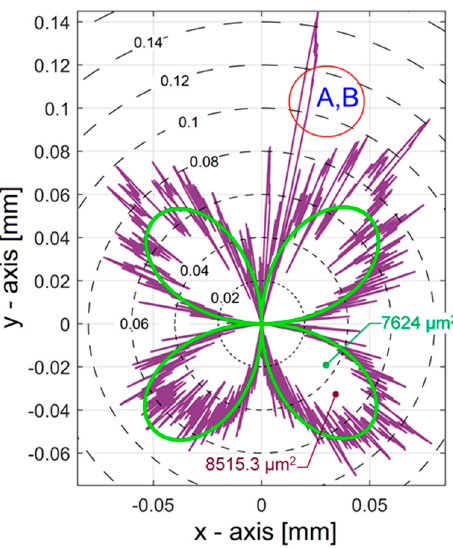
Figure 14. The evolution of TFR 1 generated by x e and y e and TFR 1 generated only by x a and y a (with green color).